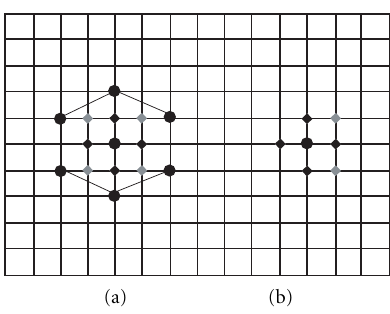
Figure 3: (a) All possible shapes of the hexagonal pattern when it reaches the left/right or the up/down limits of the search area. (b) Possible star shapes (initial and expanded) for a down/up or right edge MBD points.